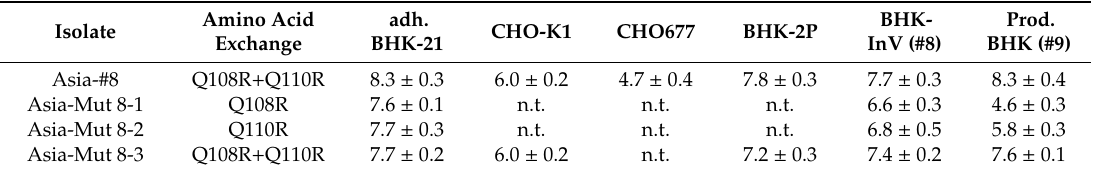
Table 3. Mean and standard deviation of viral titers (log 10 TCID 50 / mL) of virus strain Asia-#8 and the corresponding recombinant